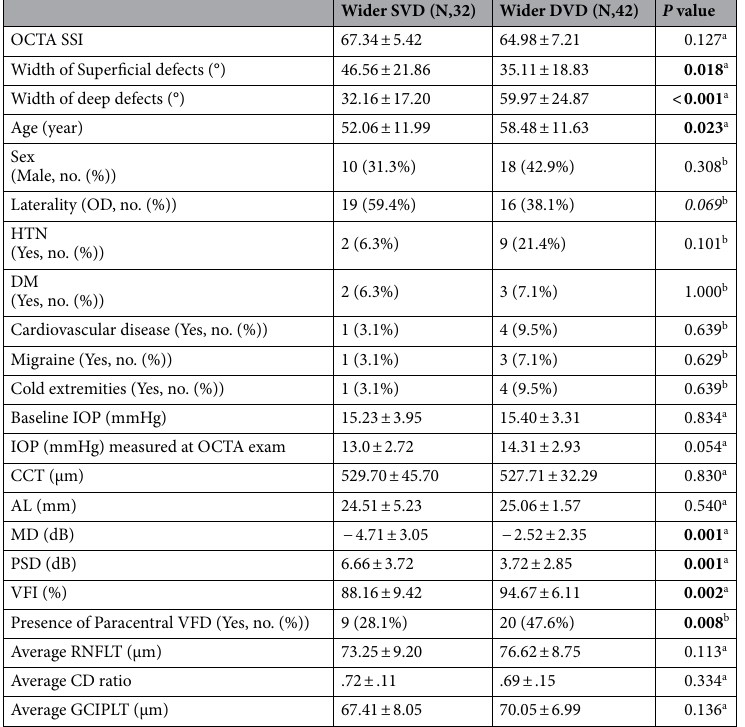
Table 1. Patient’s demographics. SVD superficial vessel defect, DVD deep vessel defect, n = number, OCTA optical coherence tomography angiography, SSI signal strength index, HTN hypertension, DM diabetes mellitus, IOP intraocular pressure, CCT central corneal thickness, AL axial length, MD mean deviation, dB decibel, PSD pattern standard deviation, VFI visual field index, VFD visual field defect, RNFLT retinal nerve fiber layer thickness, CD cup disc, GCIPLT ganglion cell inner plexiform layer thickness. Mean values are presented with standard deviations. Bold font indicates significant P values ( P < 0.05). a Student’s t-test. b Chi- squared